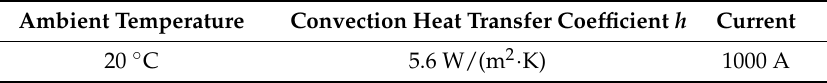
Table 4. Simulation parameters.